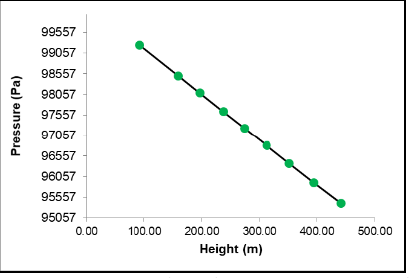
Figure 21. Vertical profile of pressure during the